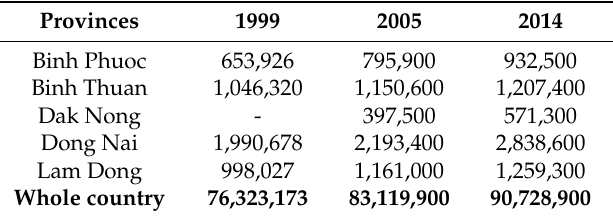
Table 6. Population (person) [28,46].